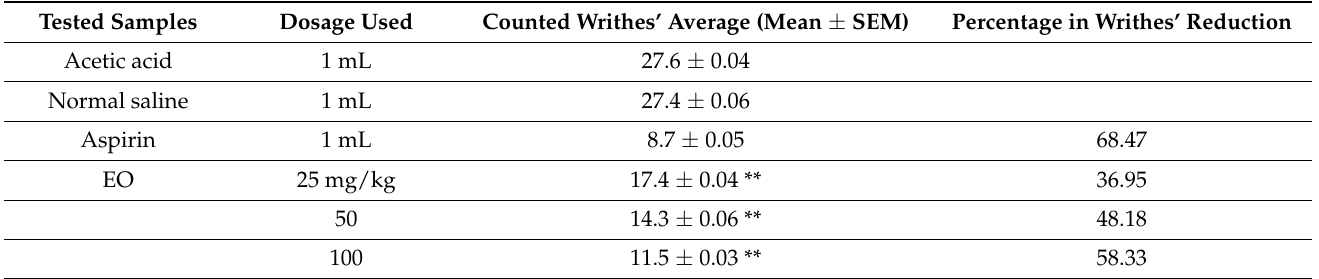
Table 4. Analgesic capabilities of